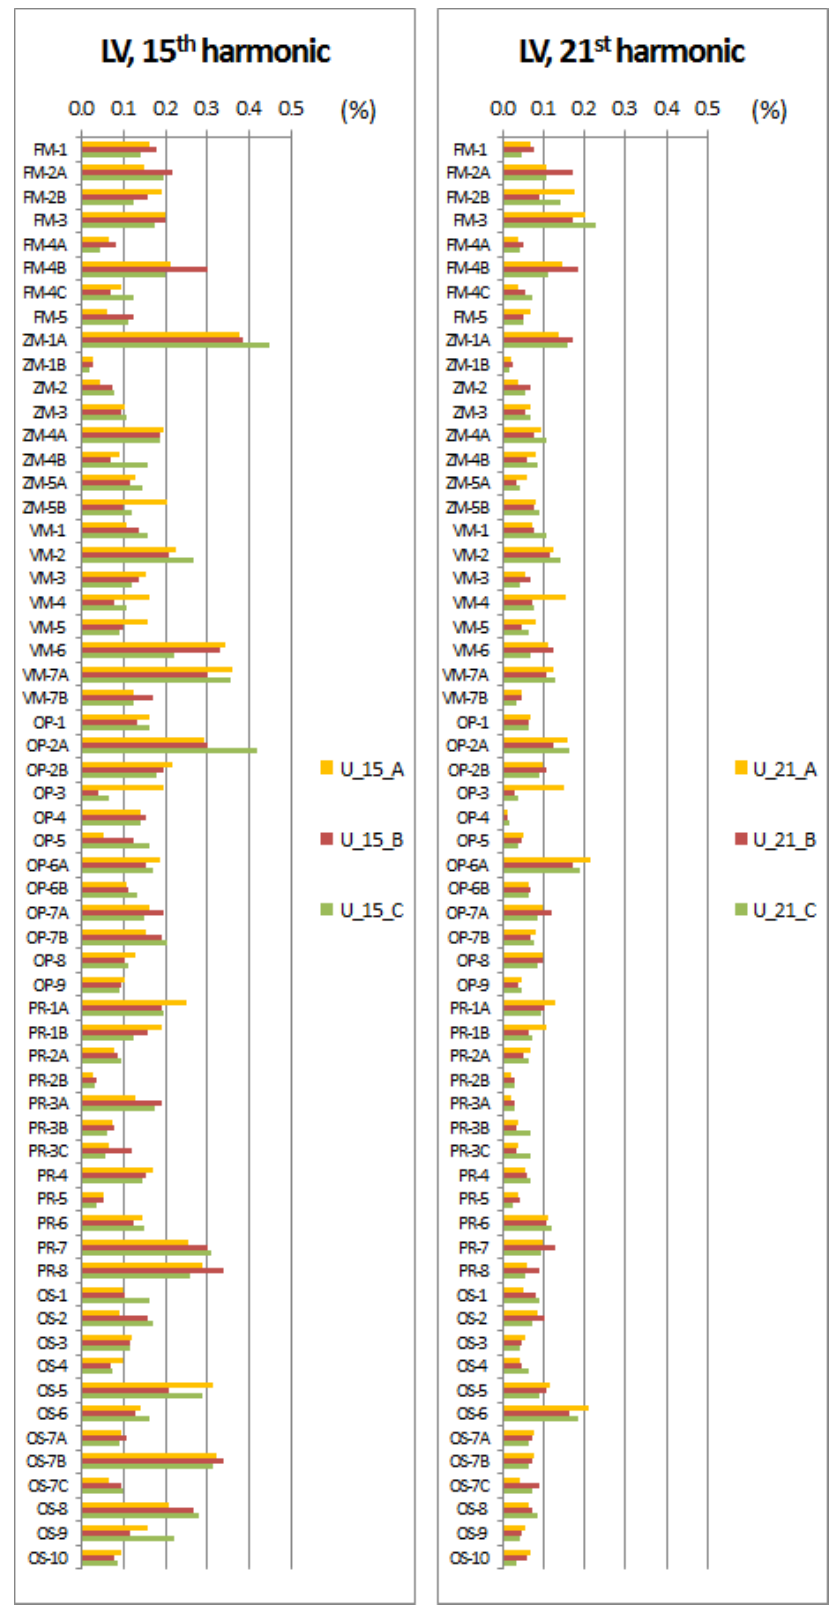
Fig. 4. The results of the measuring and evaluation of the 15 th and 21 st voltage harmonics in the LV distribution